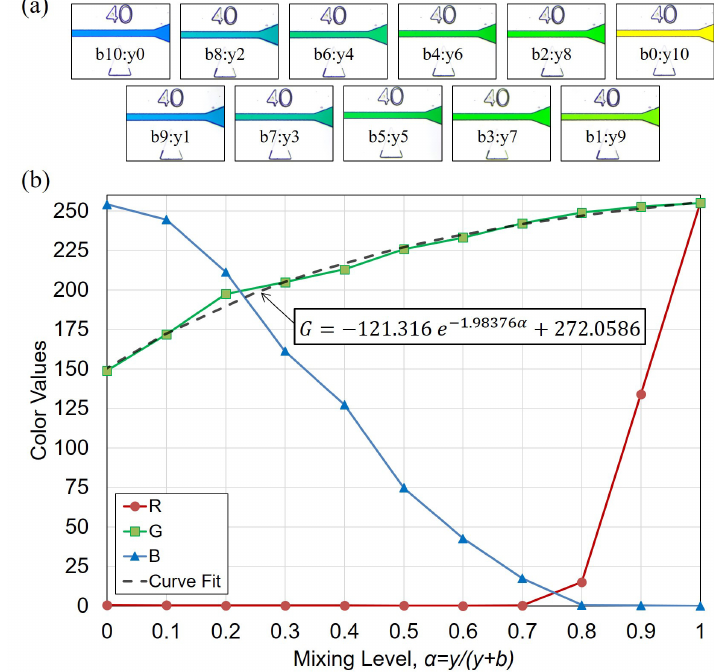
Figure 4. The calibration of color components and mixing ratio. ( a ) Images of reference colors in the channel. ( b ) R, G, B components at different mixing levels α